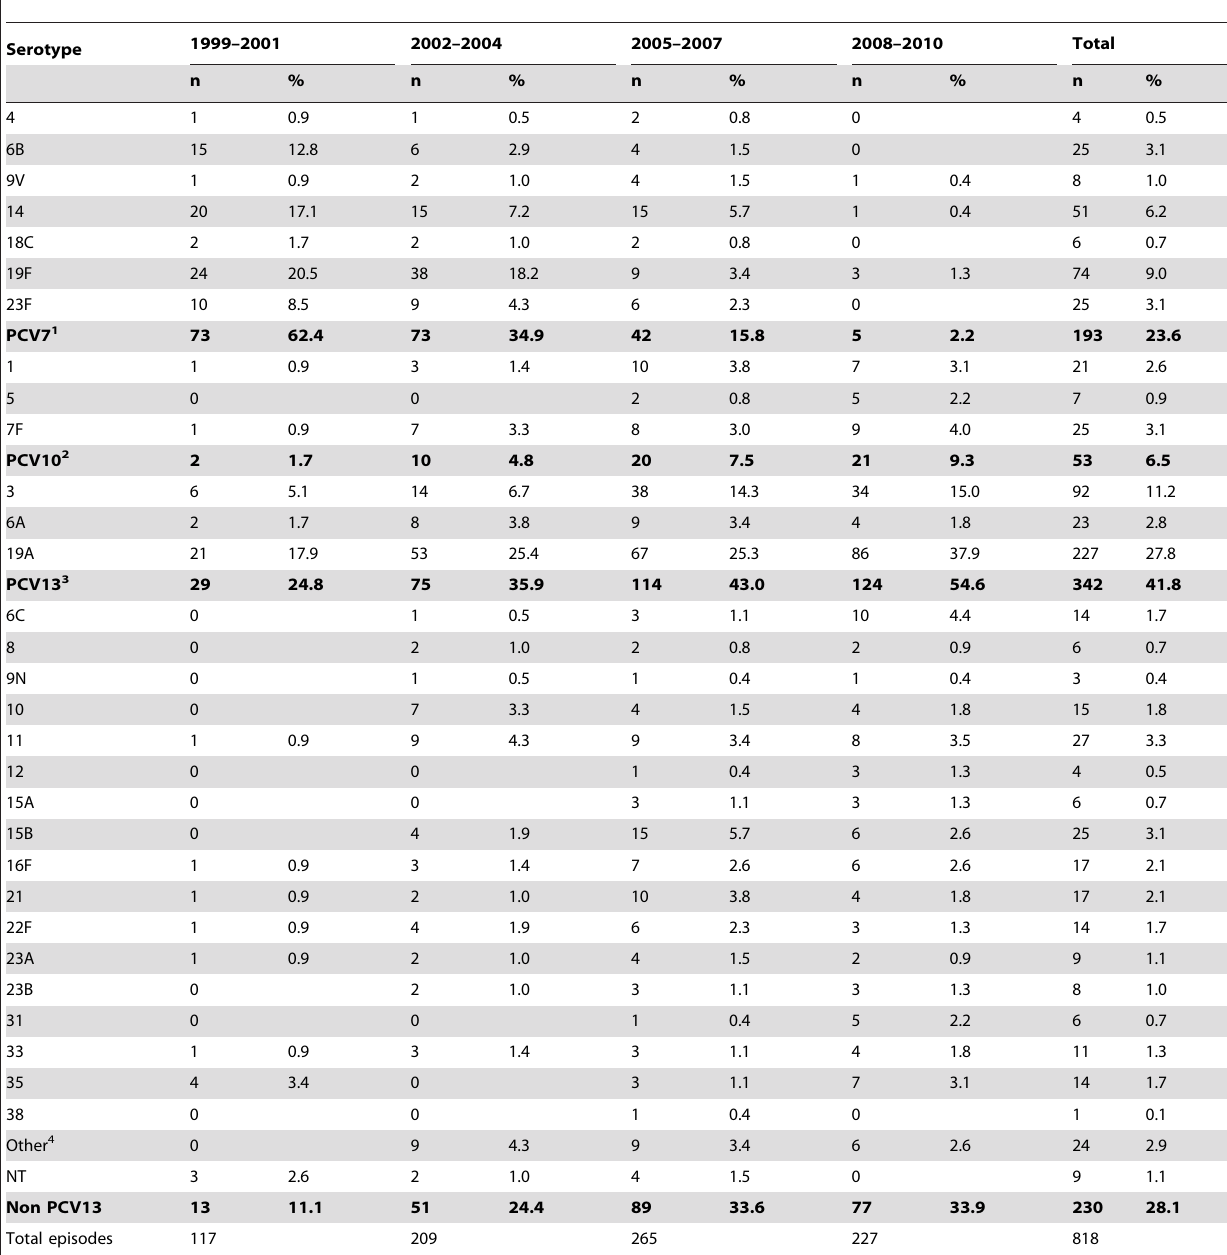
Table 2. Serotype distribution of pneumococci isolated from 1 episodes of acute otitis media from children less than 5 years of age in Gipuzkoa, Northern Spain